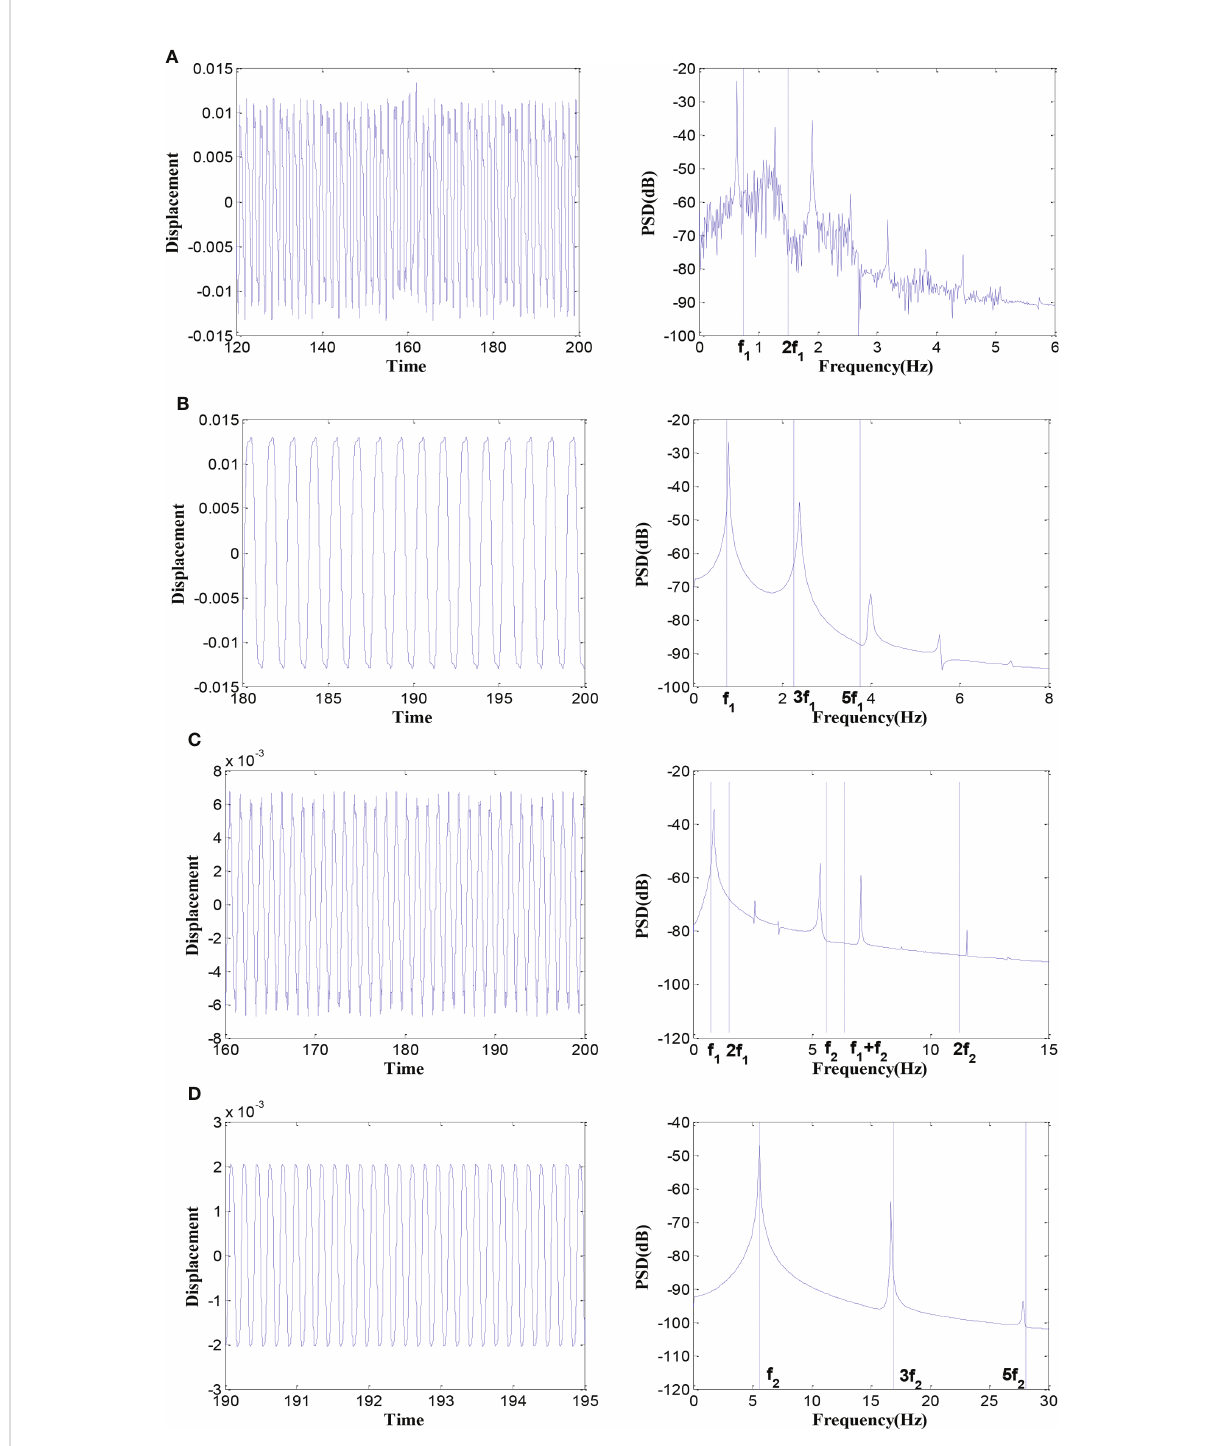
FIGURE 13 Time history (left) and power spectral density map (right) of the midpoint of the pipe at different pulsating frequencies (when m = 0.6). (A) w p = 8; (B) w p = 10; (C) w p = 39; (D) w p =